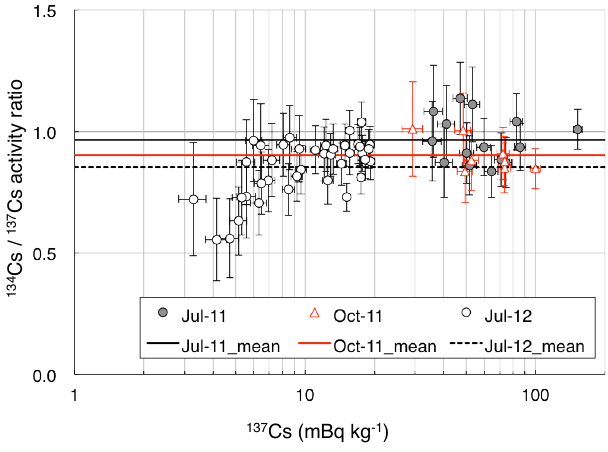
Fig. 4. Relationship between concentrations of 137 Cs decay cor- rected on sampling date and 134 Cs/ 137 Cs activity ratio decay cor- rected on 6 April 2011, when the maximum direct radioactivity dis- charged into the ocean (Buesseler et al., 2011).